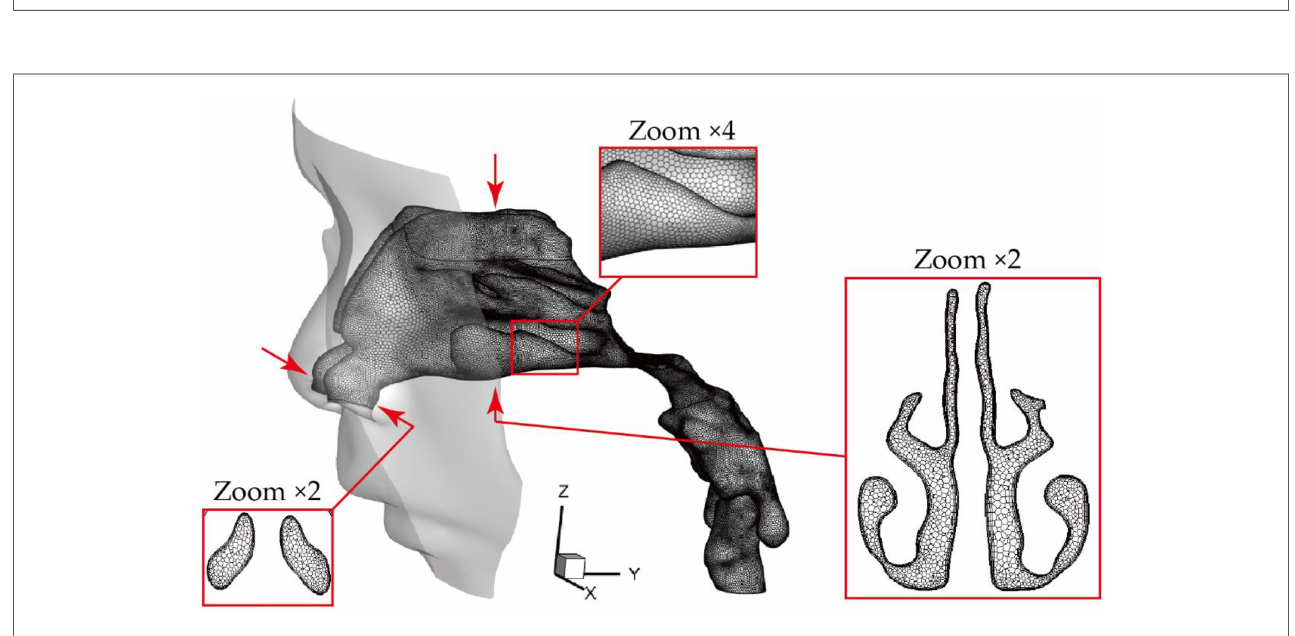
FIGURE 1 Nasal airway models based on obstructed nasal airway: ( A ) CT image showing the presence of the abnormal adenoid tissue – adenoid hypertrophy; ( B ) reconstructed nasal airway model with nasopharynx obstruction – pre-operative model; ( C ) restored normal nasal airway after virtual adenectomy – post- operative model. Note, to produce realistic fl ow fi elds and exposure conditions, a spherical breathing region with a radius of 80 mm was added to enclose the nares and external nose region.